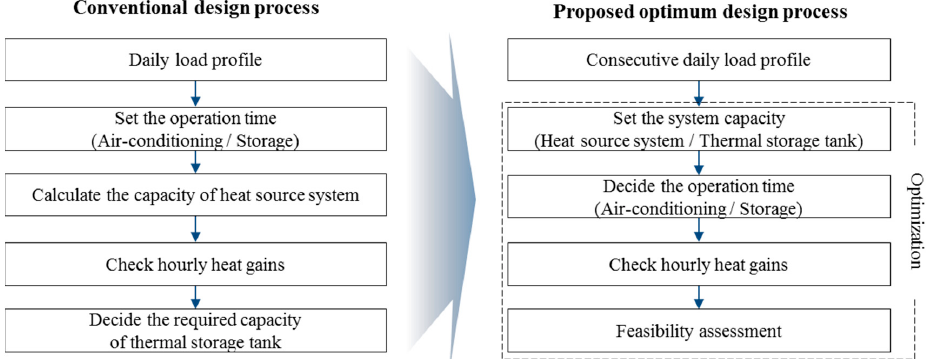
Figure 1. Changes in the design process of thermal storage system.